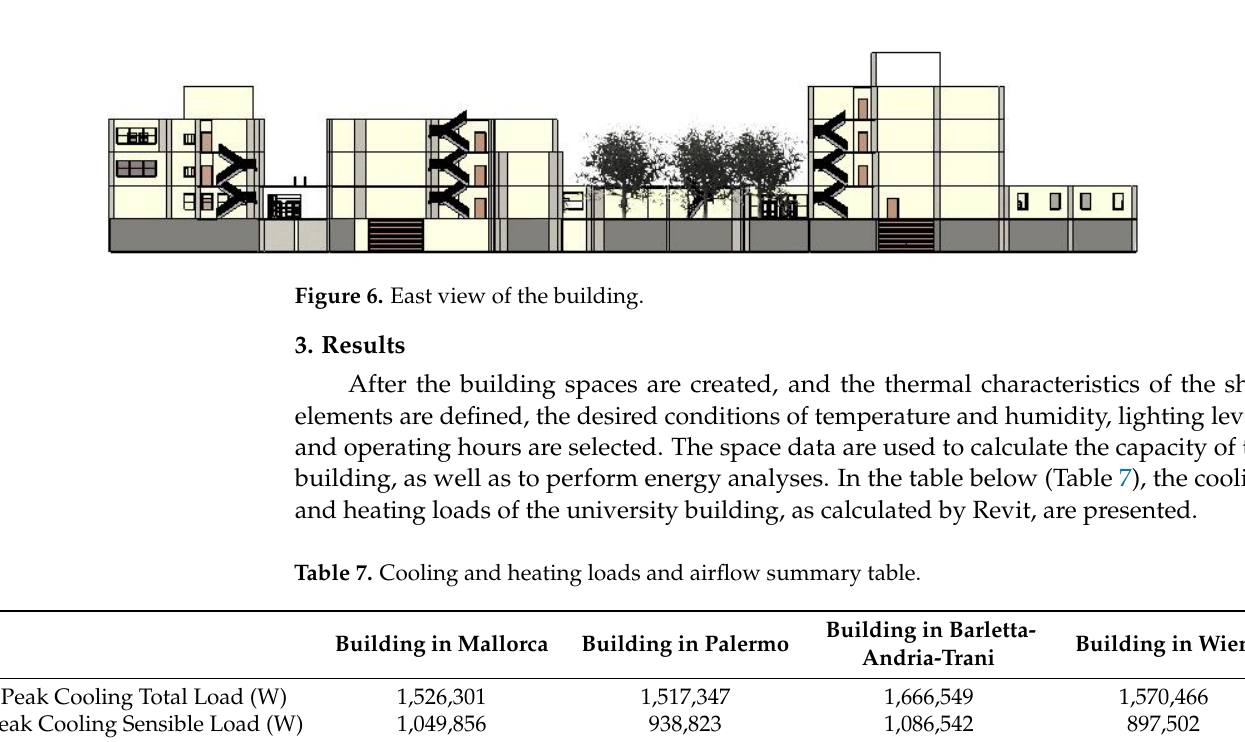
Figure 5. North view of the building.